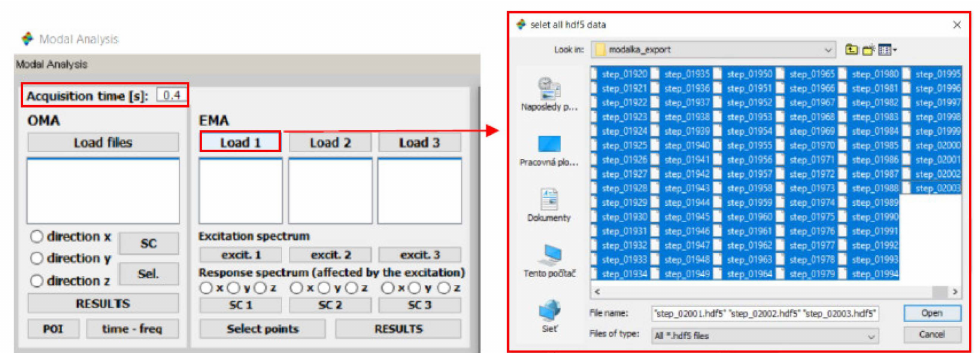
Figure 9. Initial GUI window for determining modal parameters.